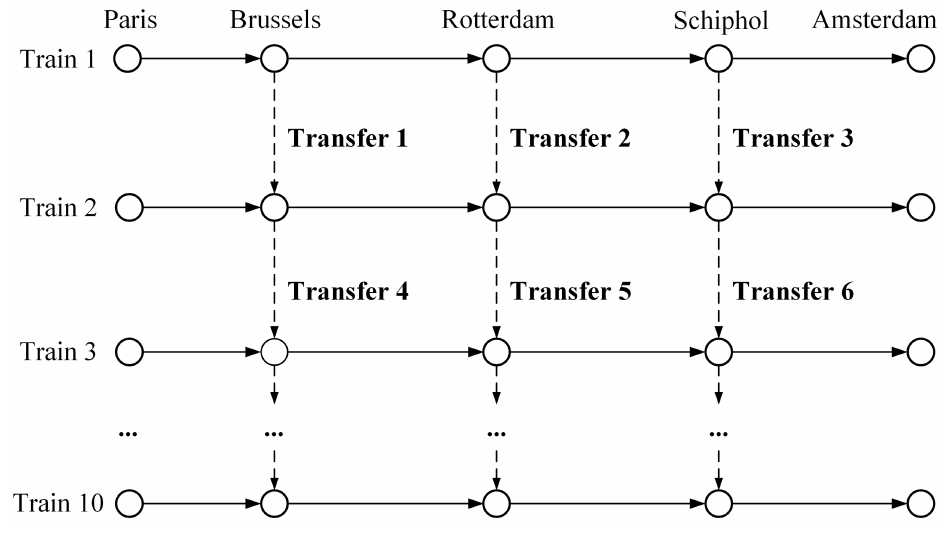
Fig 9. Available